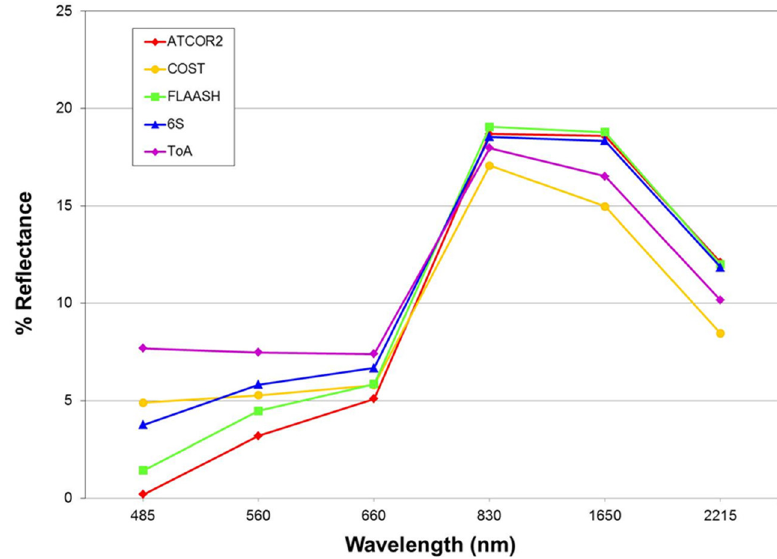
Figure 4. Spectral performance of each of the radiometric correction algorithms considered.